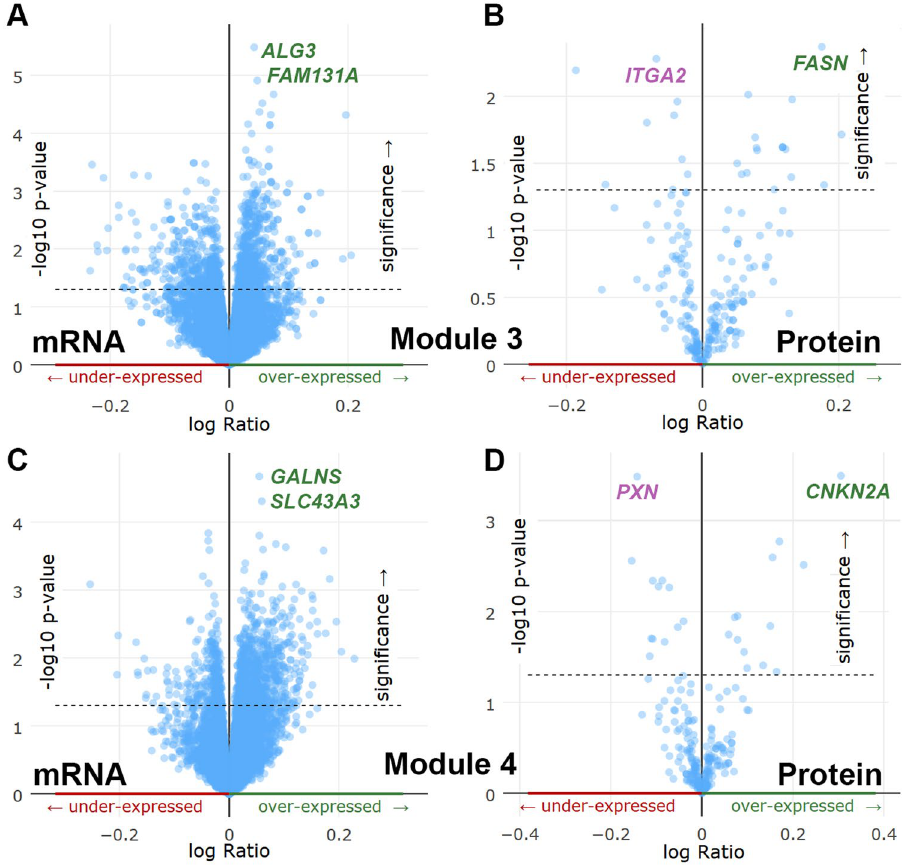
Figure 6. Enrichment analysis of mutated genes against TCGA ovarian cancer mRNA expression and protein expression dataset for module 3 and 4. Plots represent samples with mutated genes from module 3 overlapping to ( A ) gene expression and ( B ) protein expression in the same ovarian cancer samples. Plots represent samples with mutated genes from module 4 overlapping to ( C ) gene expression and ( D ) protein expression in the same ovarian cancer